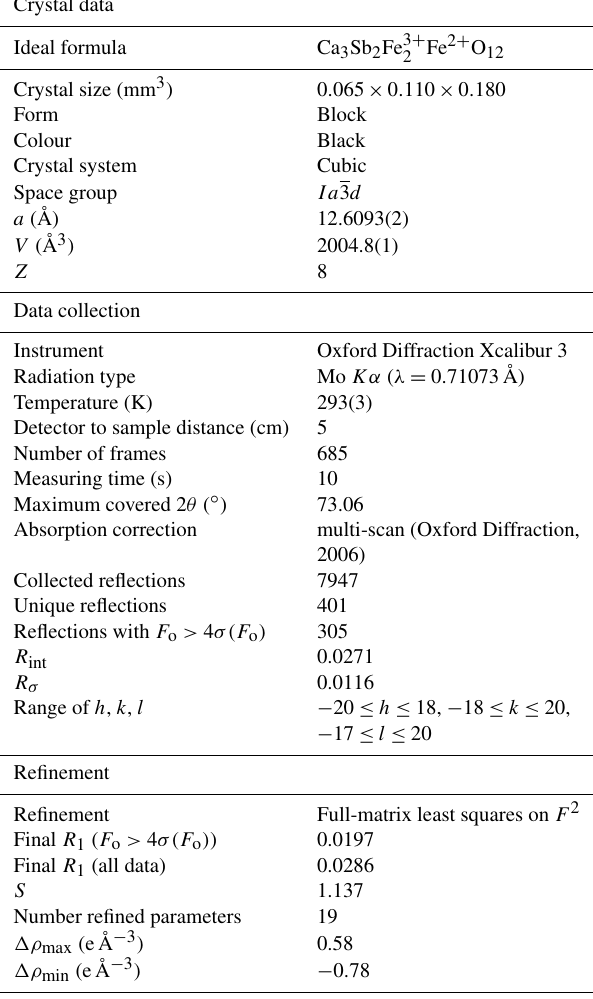
Table 5. Data and experimental details for the selected monten- eveite